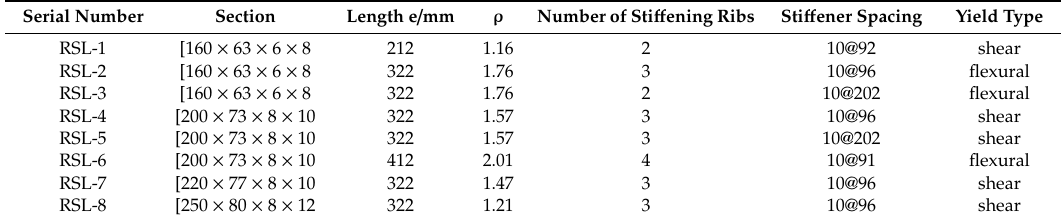
Table 1. Parameter table of